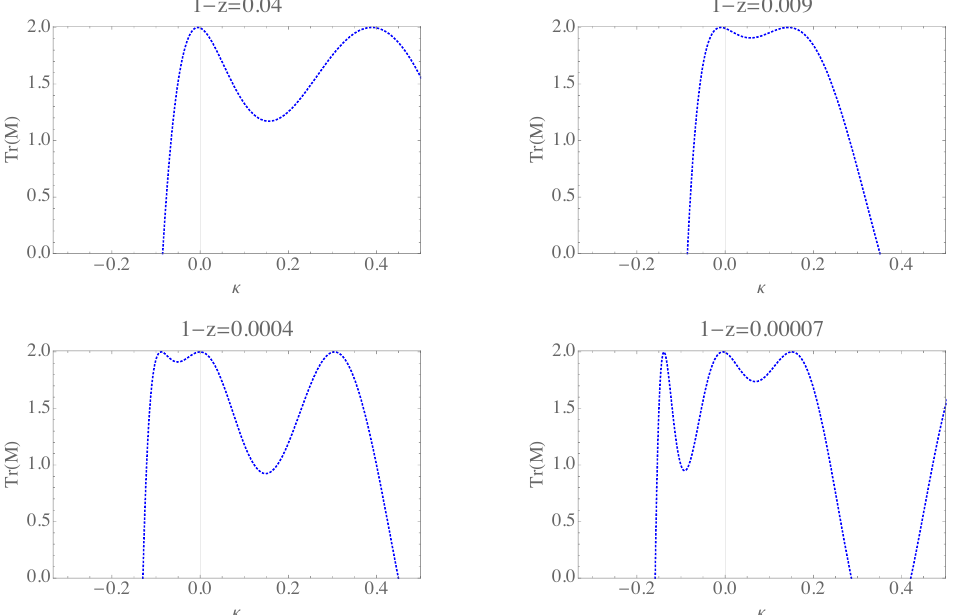
Figure 10 . Plot of Tr( M ) (using (2.33)) as z comes very close to 1. Troughs of the sinusoid become increasingly shallow as they approach (cid:20) = 0, and then become deeper again after they pass to (cid:20) < 0. Therefore solutions to Tr( M ) = 2 cos( (cid:25)(cid:11) I ) approach (cid:20) = 0, then move o(cid:11) into the (cid:0) complex plane to circle around (cid:20) = 0, and then move back onto the real axis again, but at negative real (cid:20) . Parameters (cid:11) L ; (cid:11) H are the same as in (cid:12)gure 9. see that the (cid:12)rst (farthest left) trough rises quite signi(cid:12)cantly. Eventually it rises above the horizontal line at 2 cos( (cid:25)(cid:11) I ), 13 and at this point the (cid:20) solution moves o(cid:11) into the (cid:0) complex plane. In (cid:12)g 10, we plot what happens as z moves even closer to 1, in the case (cid:11) H = i; (cid:11) L = 0 : 99. There, one can see that the troughs of the sinusoid become increas- ingly shallow as they approach (cid:20) = 0. Eventually, they pass through (cid:20) = 0 and move to negative (cid:20) , and start to become increasingly deep again. At some point, they will be deep enough to intersect the horizontal line 2 cos( (cid:25)(cid:11) I ) again, at which point the corresponding (cid:0) solution for (cid:20) becomes real again. From that point on, they continue moving to the left, asymptotically approaching the value (cid:20) = 1 ( (cid:11) 2 + (cid:11) 2 1) (which is always negative in the H L (cid:0) 4 region h H > c > h L that we are 24